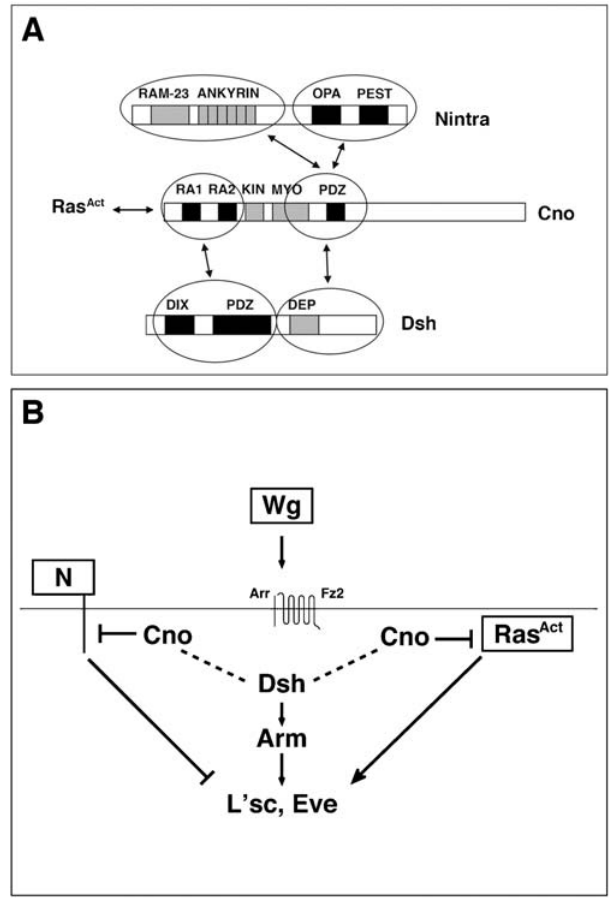
Figure 8. Summary of physical interactions and working model. (A) Diagram summarizing the physical interactions between Cno and Nintra, Ras Act and Dsh. (B) Working model. The modulation of the information conveyed by three signaling pathways, Wg, N and Ras- MAPK, is critical for muscle progenitor specification. Our data show that Cno interacts physically and genetically with these three pathways, negatively regulating the information flow to key progenitor transcrip- tional targets, L’sc and Eve. In this model, the Cno/Dsh interaction is pivotal to modulate signaling thresholds. Cno/Dsh interaction facilitates the release of Cno repression on Ras Act signaling and the inhibition of N signaling by Cno. Dsh recruitment by Cno leads to canonical Wg signal inhibition. Arr, Arrow; Fz2,